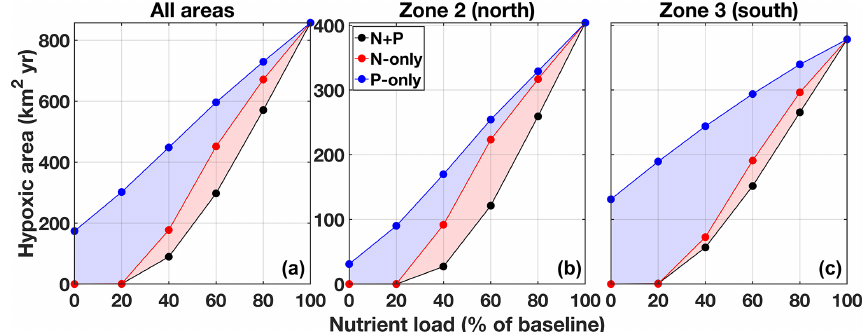
Figure 10. Effect of nutrient reduction on the size of the hypoxic area (time integrated) for zones 1–6 combined (a) , zone 2 (b) , and zone 3 (c) . The results presented are an average for 2008–2010. The equivalent for 2011–2013 is presented in the Supplement Fig. S4. Table 2. Summary of time-integrated hypoxic area (km 2 year) in the baseline and nutrient reduction experiments. Experiments are indicated as percent load relative to the